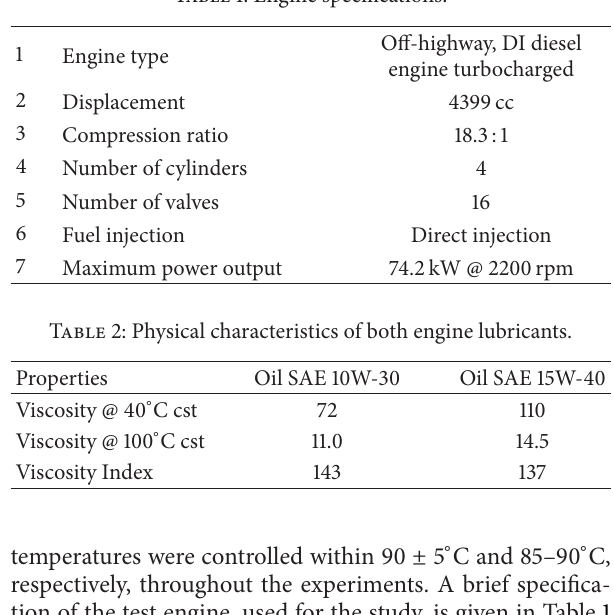
Table 1: Engine specifications.